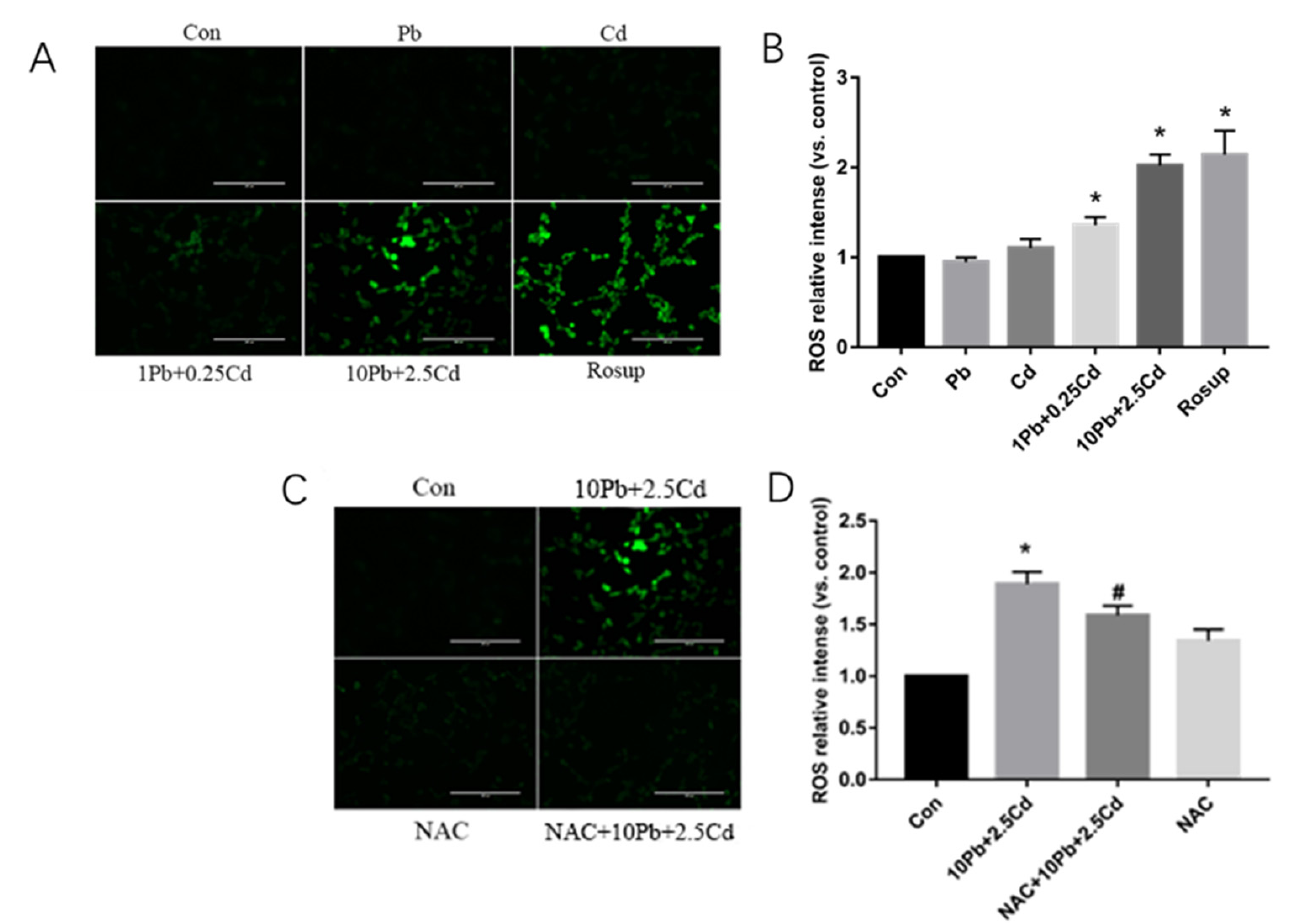
Figure 2. Effects of lead and cadmium alone or co-exposure on ROS levels in SH-SY5Y cells. Cells in the positive control group were treated with Rosup for 1 h after culturing with normal medium for 23 h. The level of intracellular ROS production was measured using a DCFH-DA fluorescent probe ( A , C ), and the fluorescence intensity was analyzed by Image J ( B , D ). An amount of 1 Pb is 1 μ mol/L Pb, and 0.25 Cd is 0.25 μ mol/L Cd. An amount of 1 Pb + 0.25 Cd is 1 μ mol/L Pb + 0.25 μ mol/L Cd mixture; 10 Pb + 2.5 Cd is 10 μ mol/L Pb + 2.5 μ mol/L Cd mixture. *, p < 0.05 compared with the control. #, p < 0.05, compared with the 10 Pb + 2.5 Cd. Data are presented as mean ± SD. Scale bar = 200 μ m.